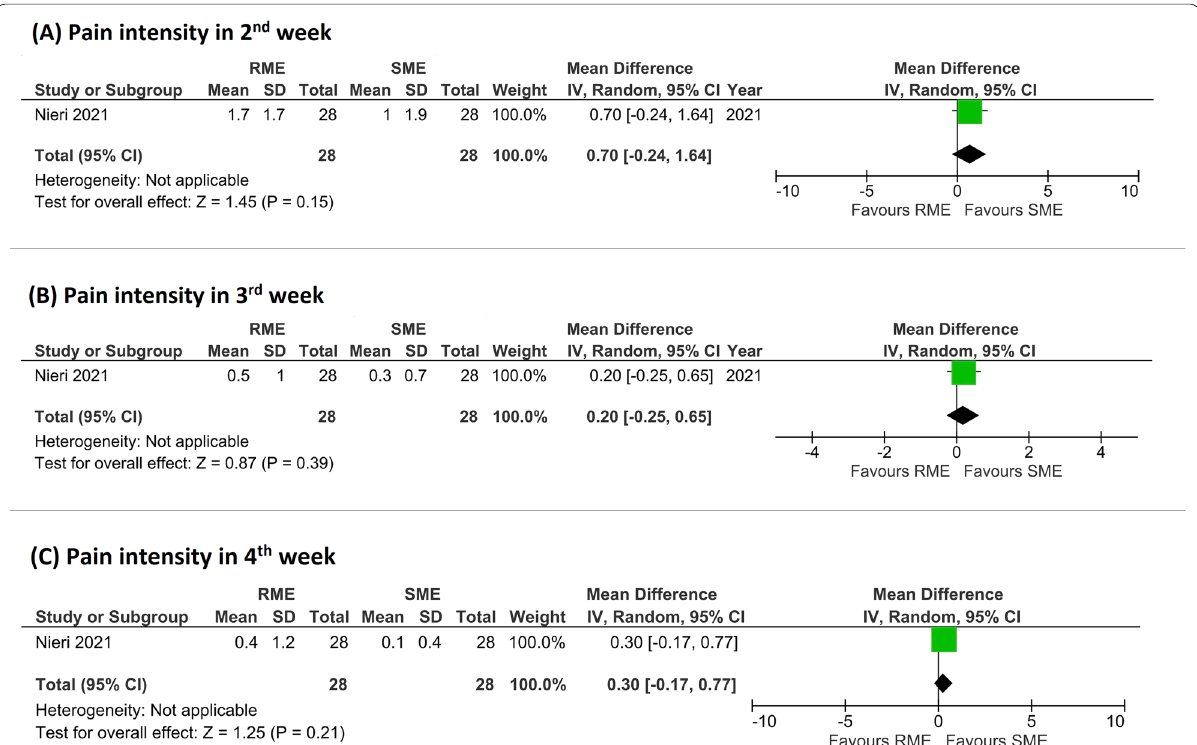
Fig. 4 Forest plots of the outcomes included in the meta-analysis ( A , pain intensity in 2nd week; B , pain intensity in 3rd week; C , pain intensity in 4th